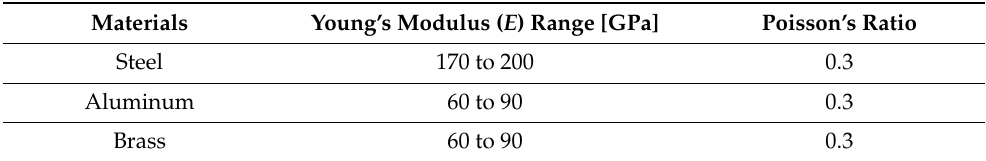
Figure 4. ( a ) Geometry model of cantilever beam, ( b ) modal analysis of natural frequencies ( f n ) under different vibration modes. Table 2. Physical properties of assigned